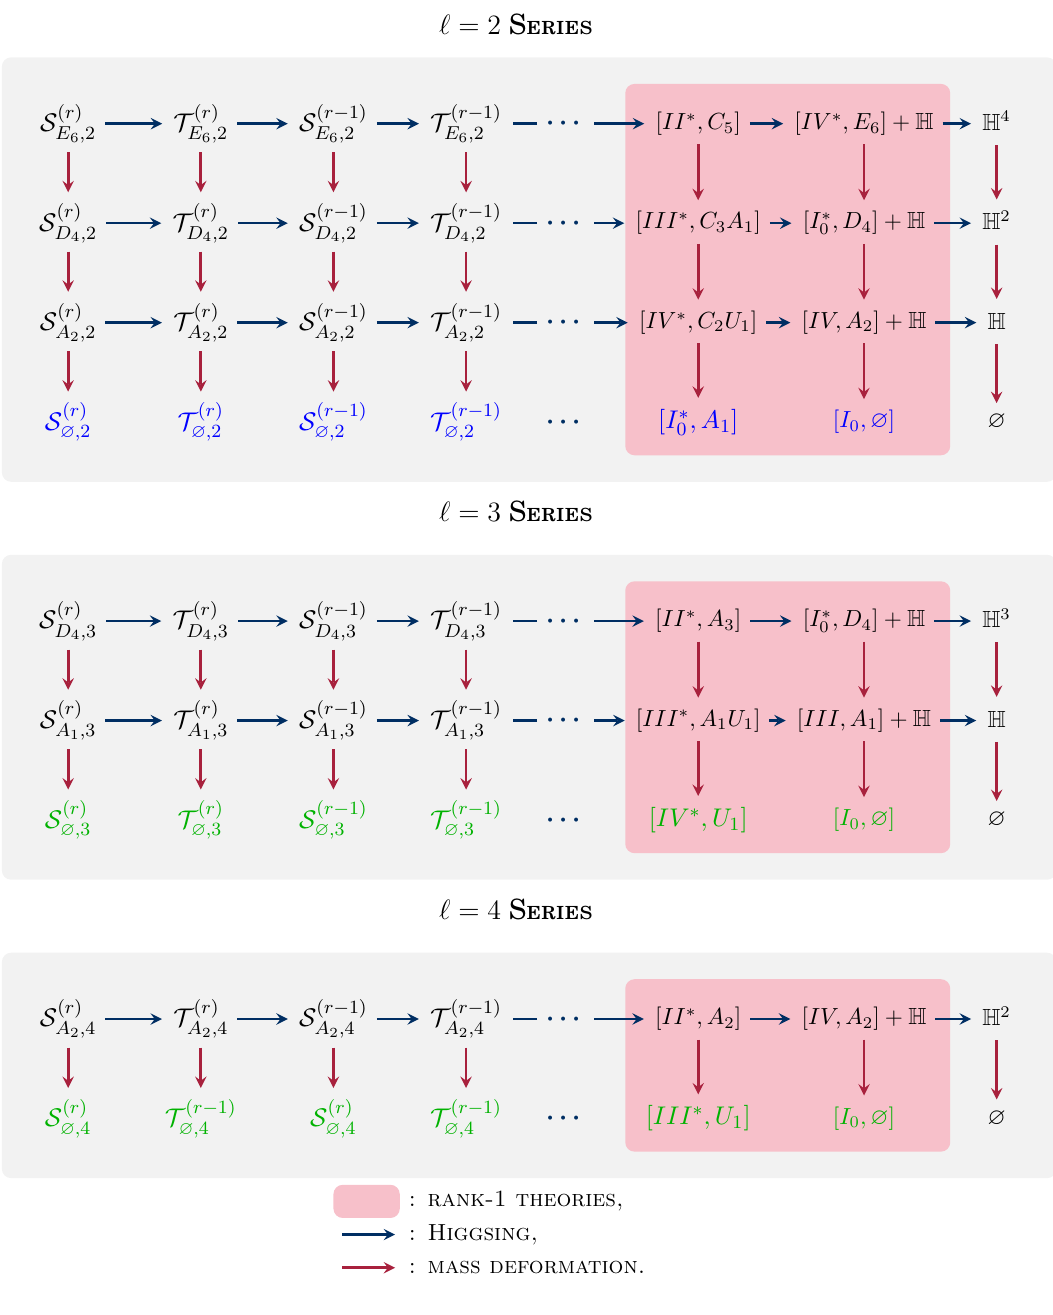
Figure 1. Graphical depiction of the RG-relations among the T and S theories for ‘ = 2, 3 and 4. Entries in green, S ( r ) and S ( r ) , are N = 3 supersymmetric, while entries in ? ;‘ =3 ; 4 ? ;‘ =3 ; 4 blue, S ( r ) ? and T ( r ) ? , are N = 4 super Yang-Mills with gauge group SO(2 r + 1) and SO(2 r ), ; 2 ; 2 respectively. We also spelled out the rank-1 theories S (1) and T (1) using the standard notation G;‘ G;‘ [Kodaira type ; (cid:13)avor